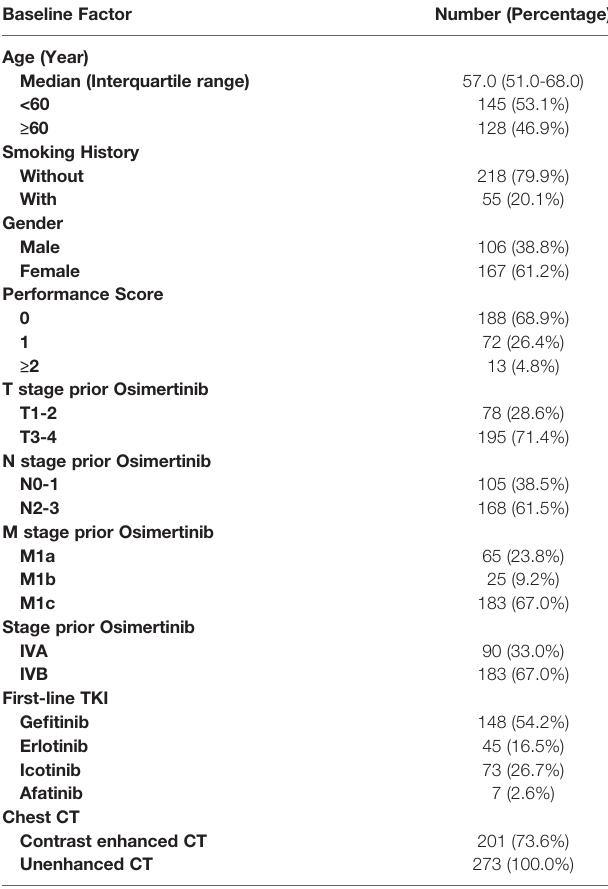
TABLE 1 | Baseline factors of the total 273 patients receiving second-line osimertinib therapy. Baseline